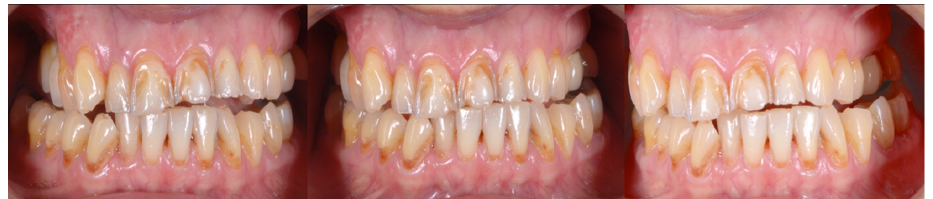
Figure 3. Occlusal changes that occurred as a result of the extensive tooth erosions compromised the physiological occlusal dynamics in protrusion and lateral movements.